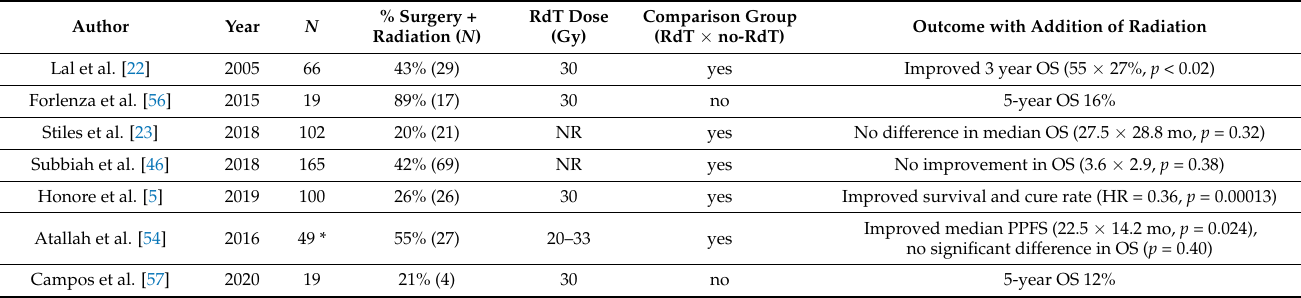
Table 1. Impact of Radiation Therapy after surgical resection in the treatment of desmoplastic small round cell tumor